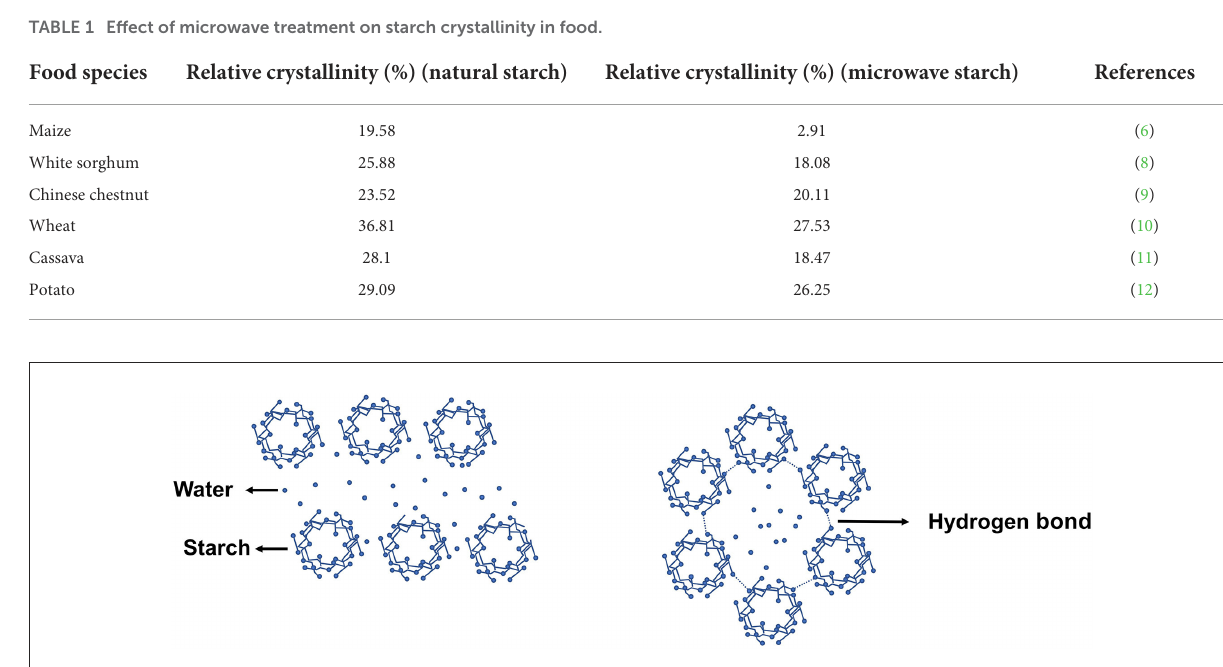
FIGURE1 The structure of starch granule.